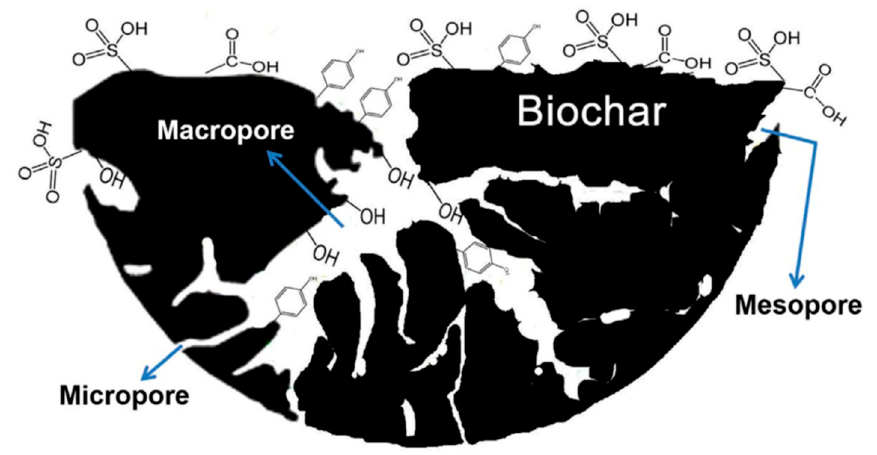
Figure 2. Morphology and the presence of functional groups in biochar. Reproduced with permission from [24]; Elsevier and Copyright Clearance Center, 2017.